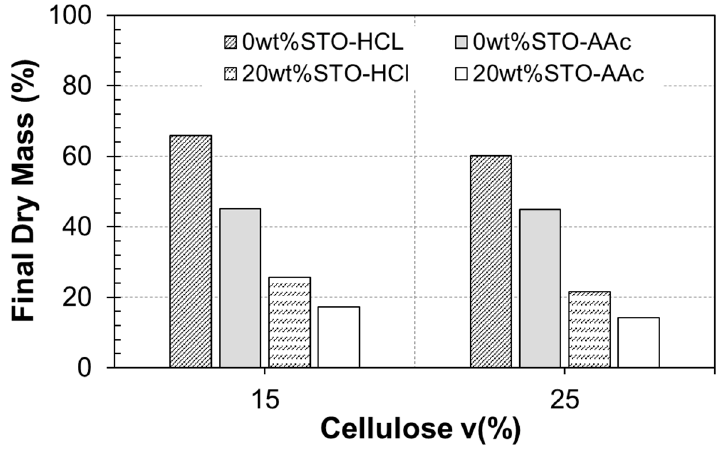
Figure 9. Dry mass for bio-chitosan/cellulose composites reinforced with STO nanoparticles.